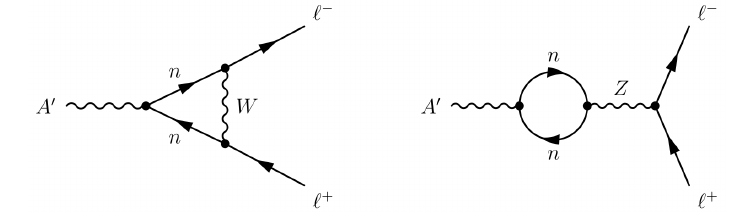
Figure 3 . The one-loop diagrams giving A 0 → ‘ − ‘ + decay. Here n = ν, χ 1 , 2 , N are mass eigen-